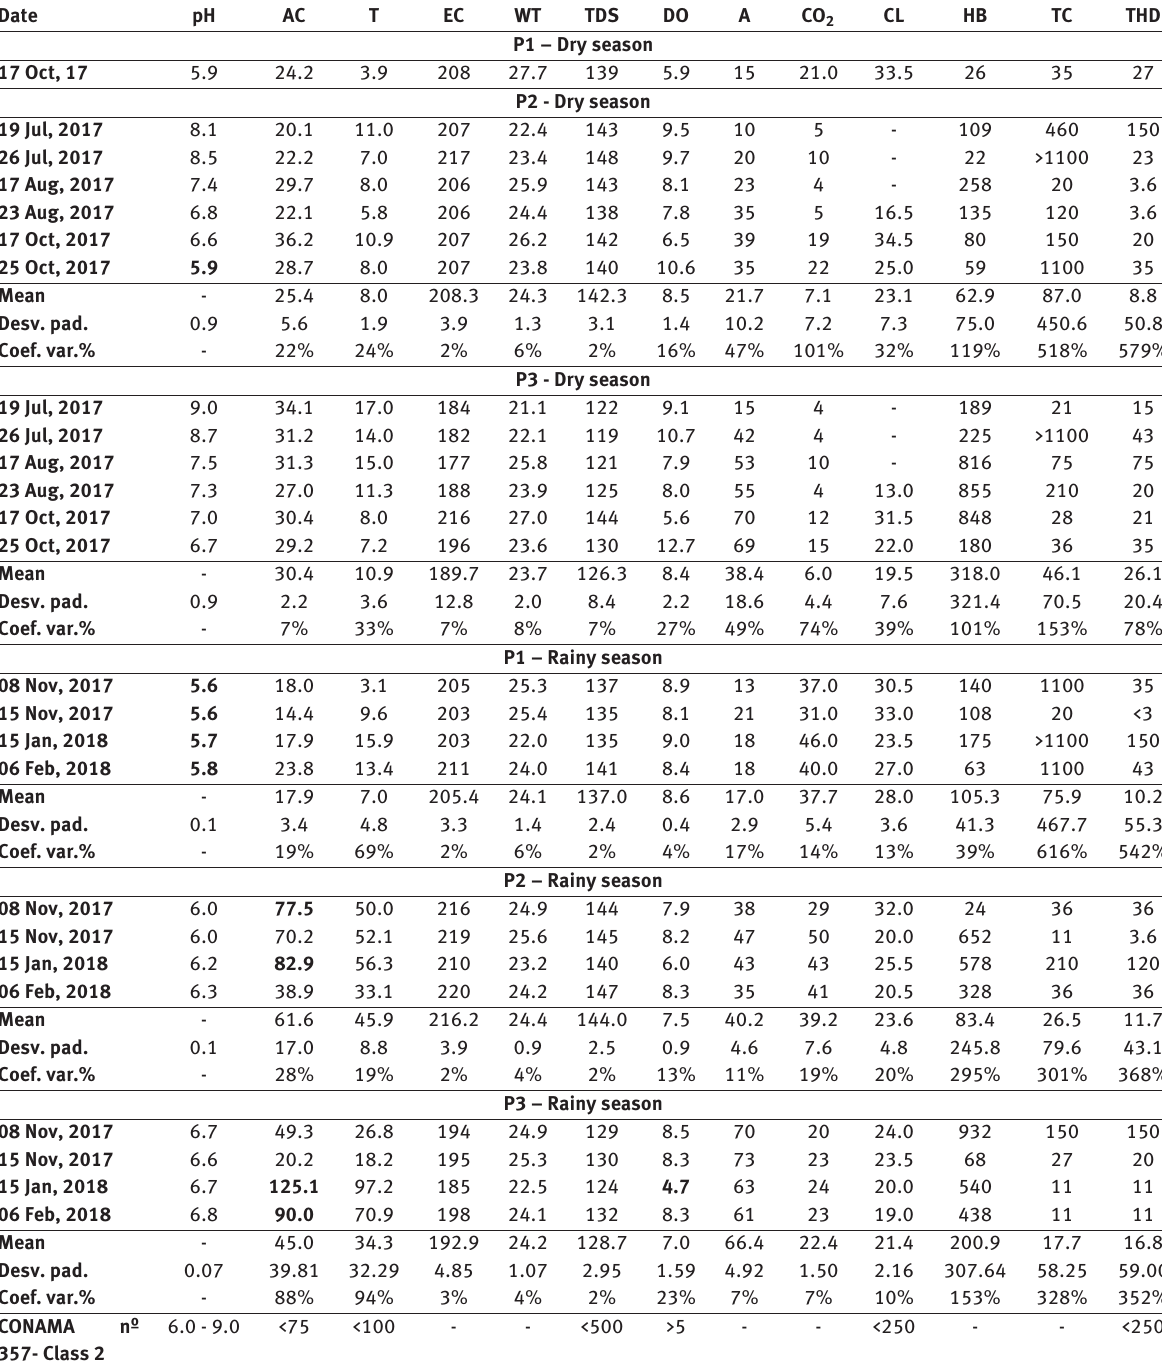
Table 3: Physical, chemical and biological parameters at the sampling points (P1, P2 and P3), as well as the maximum permitted values. Date